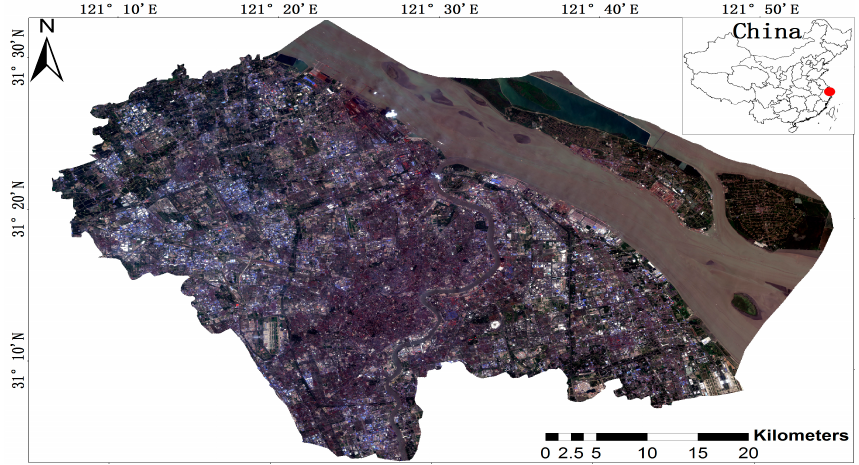
Figure 1. Location map of study area in Landsat 8 OLI natural color composite image of RGB432; inset map on top right shows the approximate location of the study area in China in red dot.